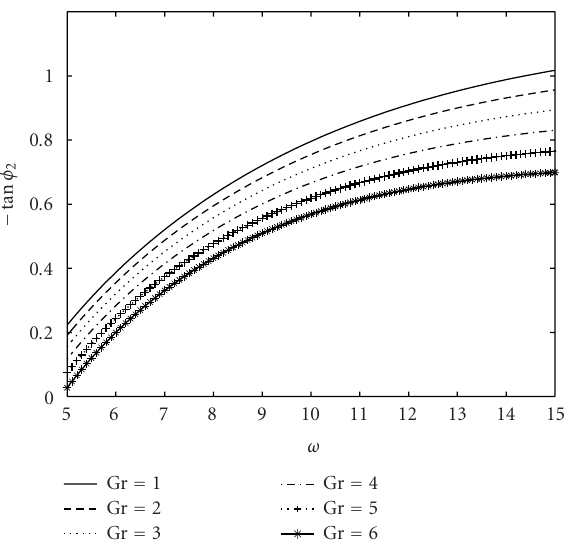
Figure 4.8. Tangent of phase shift of the shear stress due to main flow for S = 1 . 0.